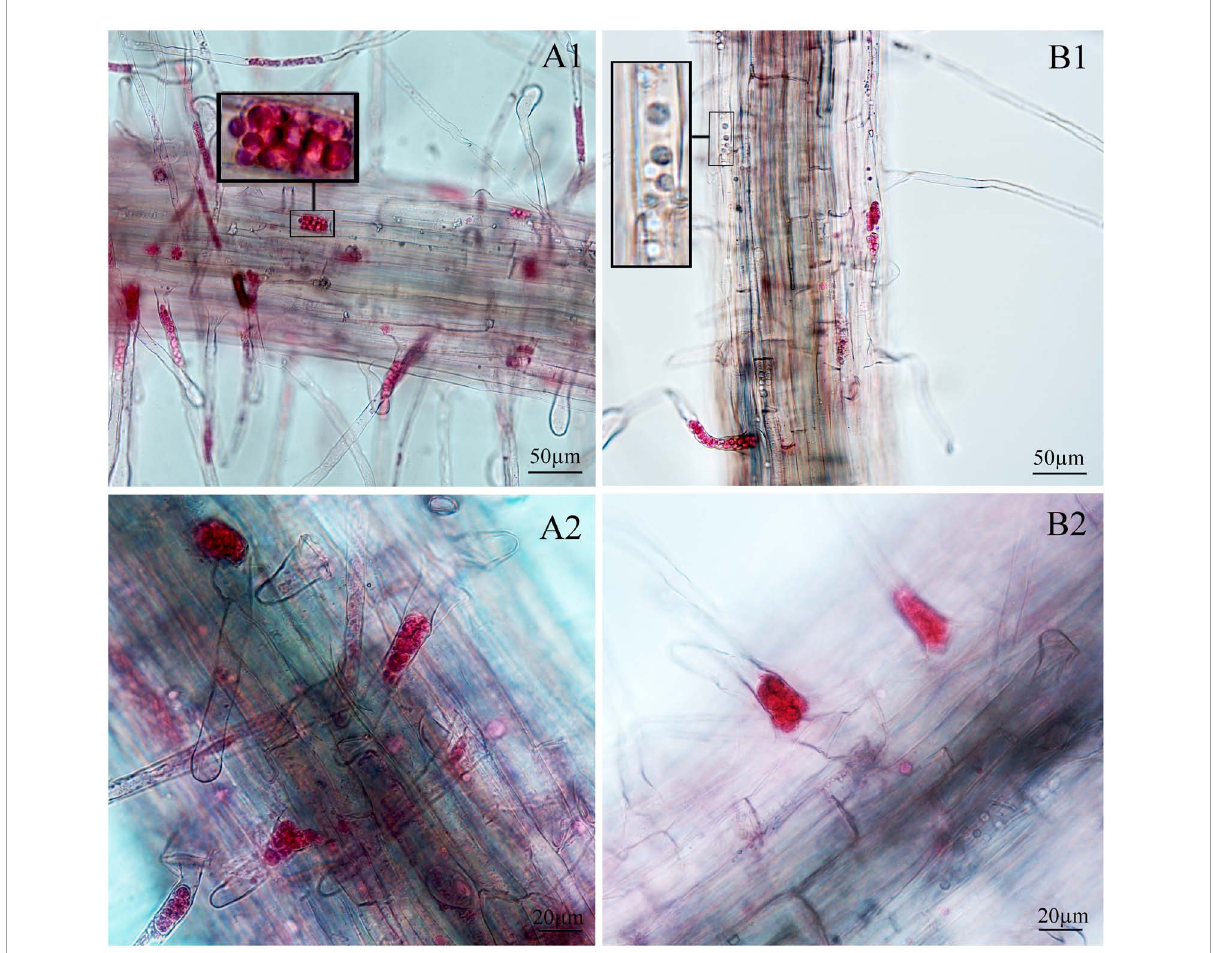
FIGURE5 Infection of spinach inoculated with resting spores. (A1,A2) Images of resting spore inoculation after 12 days. (B1,B2) Images of resting spore inoculation after 17 days.